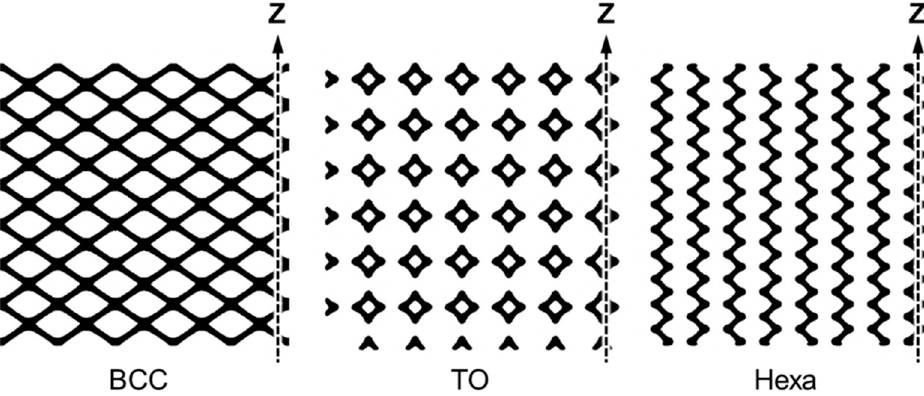
Figure 15. Cross-sections of CAD models showing the BCC, TO and Hexa lattice structures. These cross-sections include the most struts in each lattice structure.